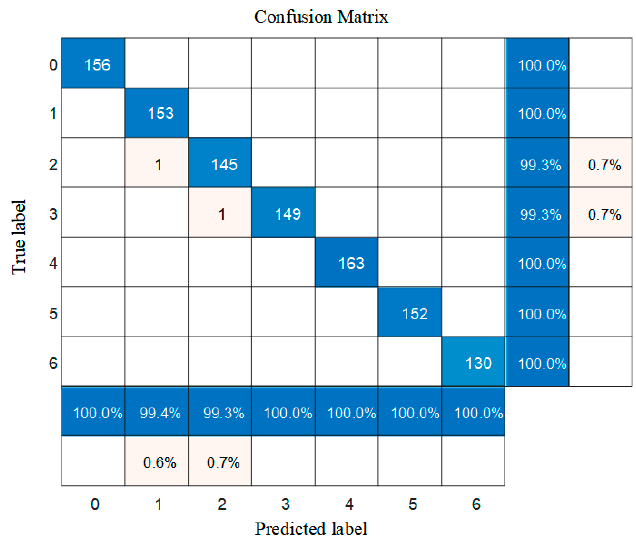
Figure 14. Confusion matrix for the result of experimental data identification .